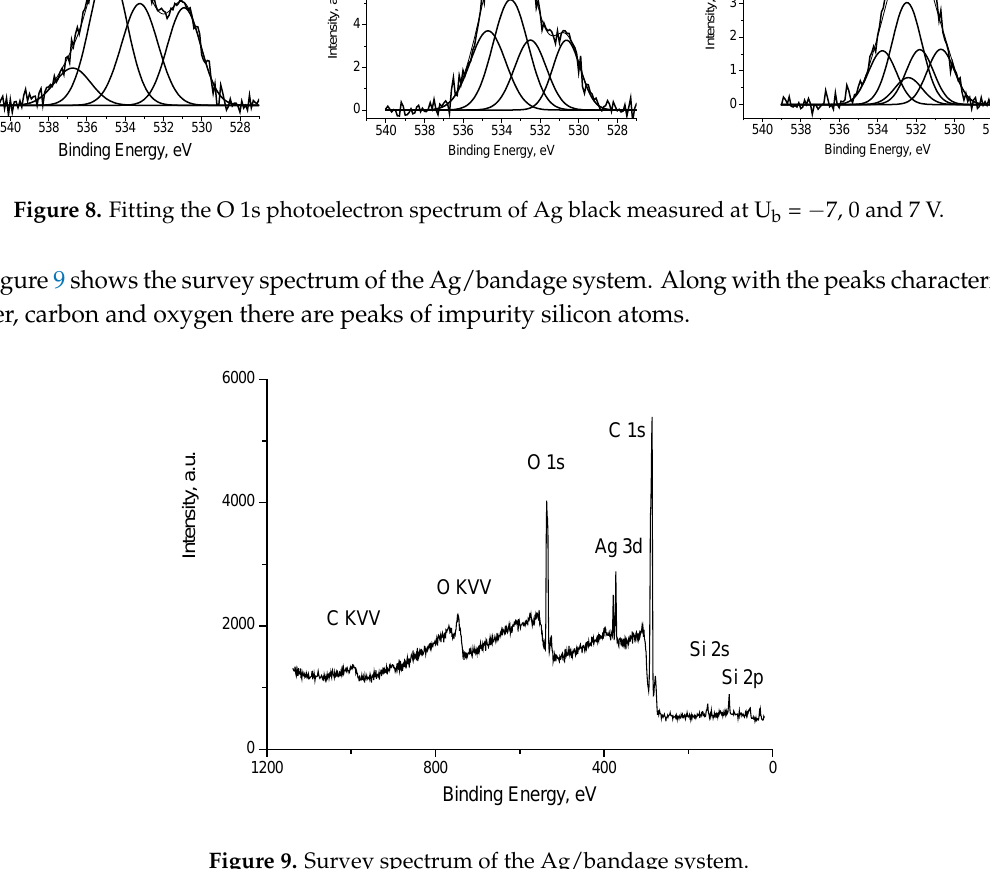
Figure 9. Survey spectrum of the Ag/bandage system.